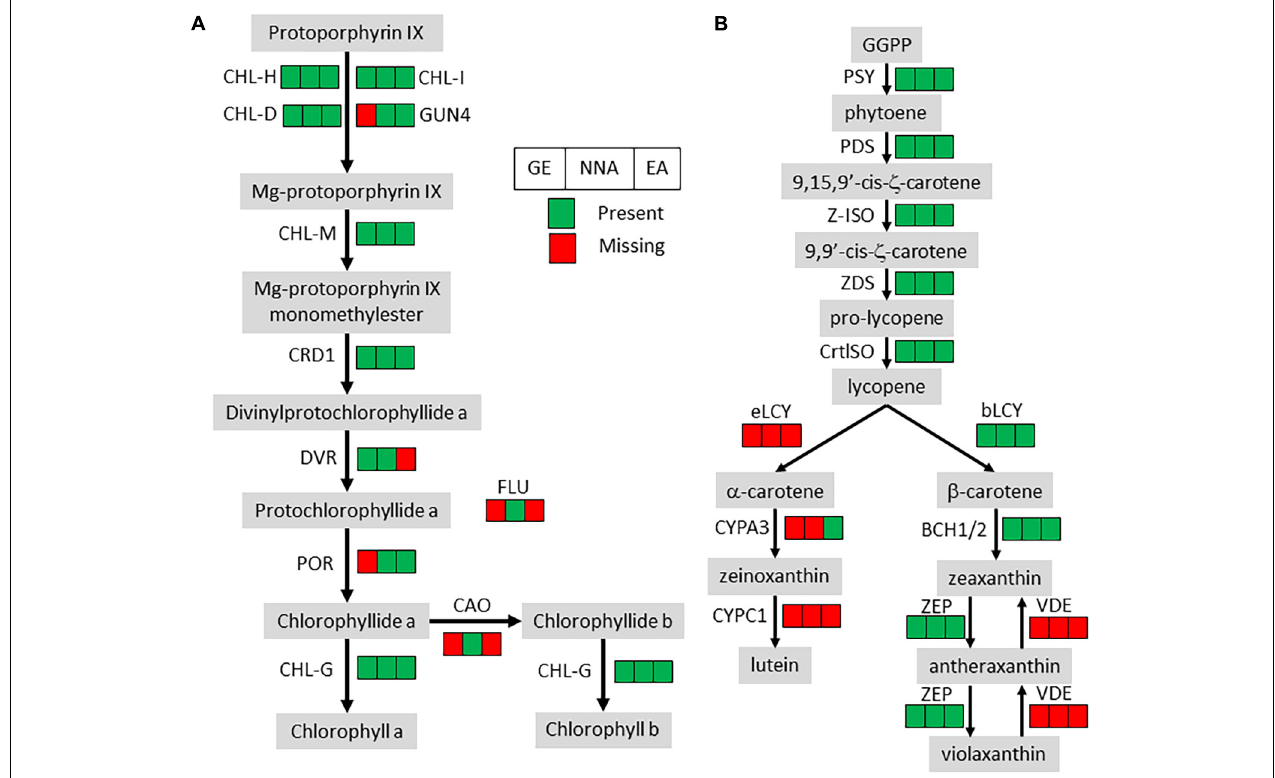
FIGURE 2 | Pigment synthesis pathways in mycoheterotrophic orchids. GE, G. elata ; NNA, N. nidus-avis ; EA, E. aphyllum ; (A) Chlorophyll biosynthesis. CHL-D, CHL-H, CHL-I, GUN4, magnesium chelatase; CHL-M, Mg-protoporphyrin IX O-methyltransferase; CRD1, Mg-protoporphyrin IX monomethylester cyclase; DVR, divinyl chlorophyllide-a 8-vinyl-reductase; POR, protochlorophyllide oxidoreductase; FLU, glutamyl-tRNA reductase regulator; CAO, chlorophyllide a oxygenase; CHL-G, chlorophyll synthase. (B) Carotenoid biosynthesis. PSY, phytoene synthase; PDS, phytoene desaturase; Z-ISO, ζ -carotene isomerase; ZDS, ζ -carotene desaturase; CrtISO, carotenoid isomerase; eLCY, lycopene ε -cyclase; bLCY, lycopene β -cyclase; BCH1/2, β -ring carotene hydroxylase; ZEP, zeaxanthin epoxidase; VDE, violaxanthin de-epoxidase; CYPA3, α -carotene β -ring hydroxylase; CYPC1, carotenoid ε -hydroxylase.